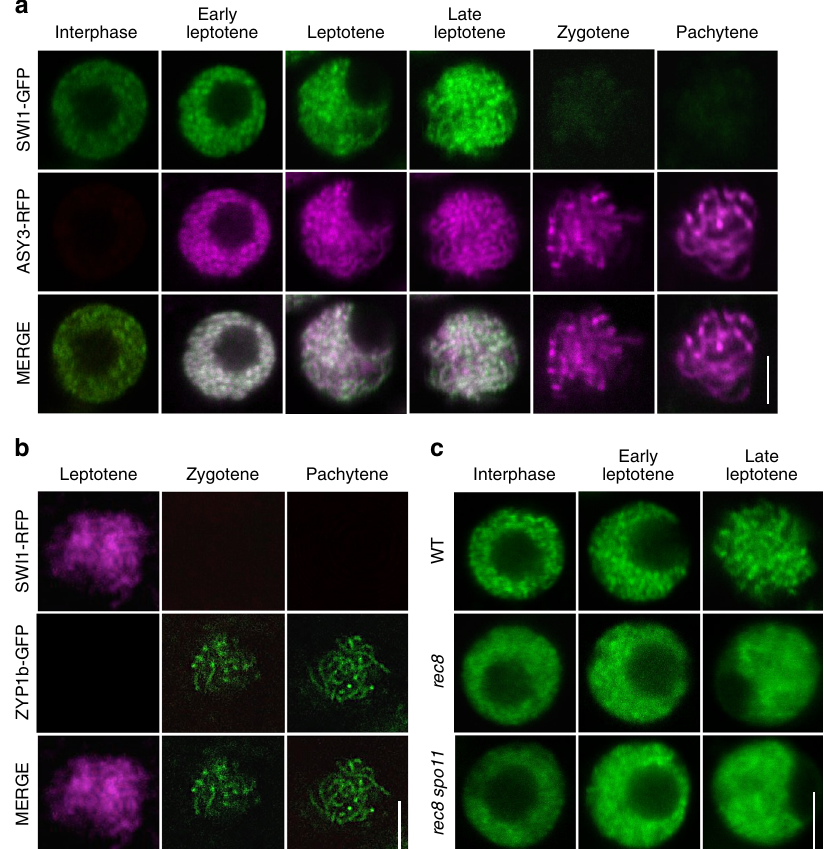
Fig. 2 Localization pattern of SWI1. Co-localization analysis of SWI1-GFP with ASY3-RFP ( a ) and SWI1-RFP with ZYP1b-GFP ( b ) during interphase and prophase I of wild-type male meiocytes using confocal scanning laser microscopy. c SWI1-GFP in the male meiocytes of the wildtype (WT), rec8 and rec8 spo11 mutants during interphase and prophase I. Bar: 5 μ